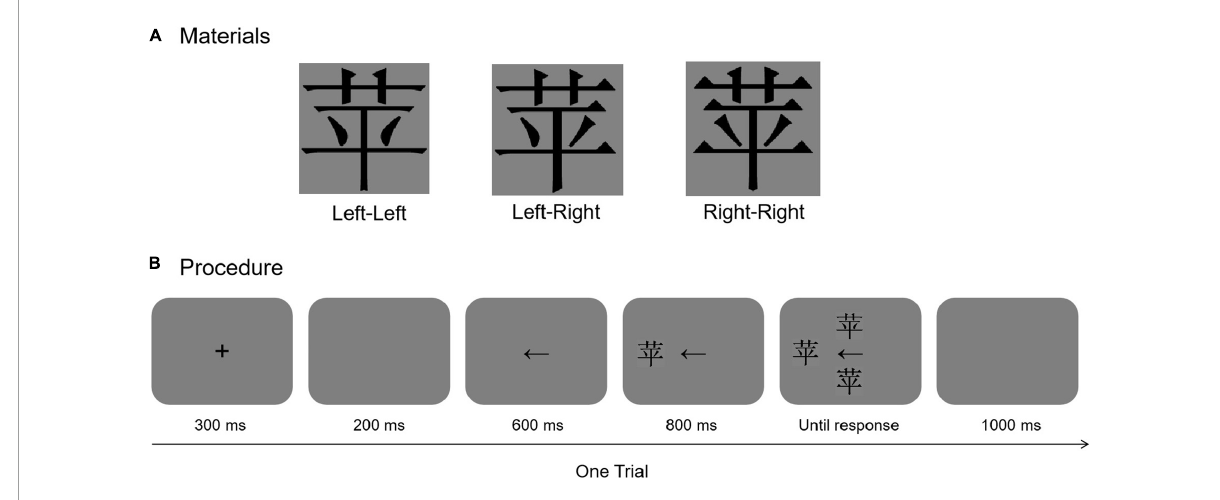
FIGURE3 (A) Example of chimeric task for Chinese characters. “Left-Left” represents a left chimeric Chinese character image; “Left-Right” represents an original Chinese character image, and “Right-Right” represents a right chimeric Chinese character image. (B) Trial structure of the left-side bias task.